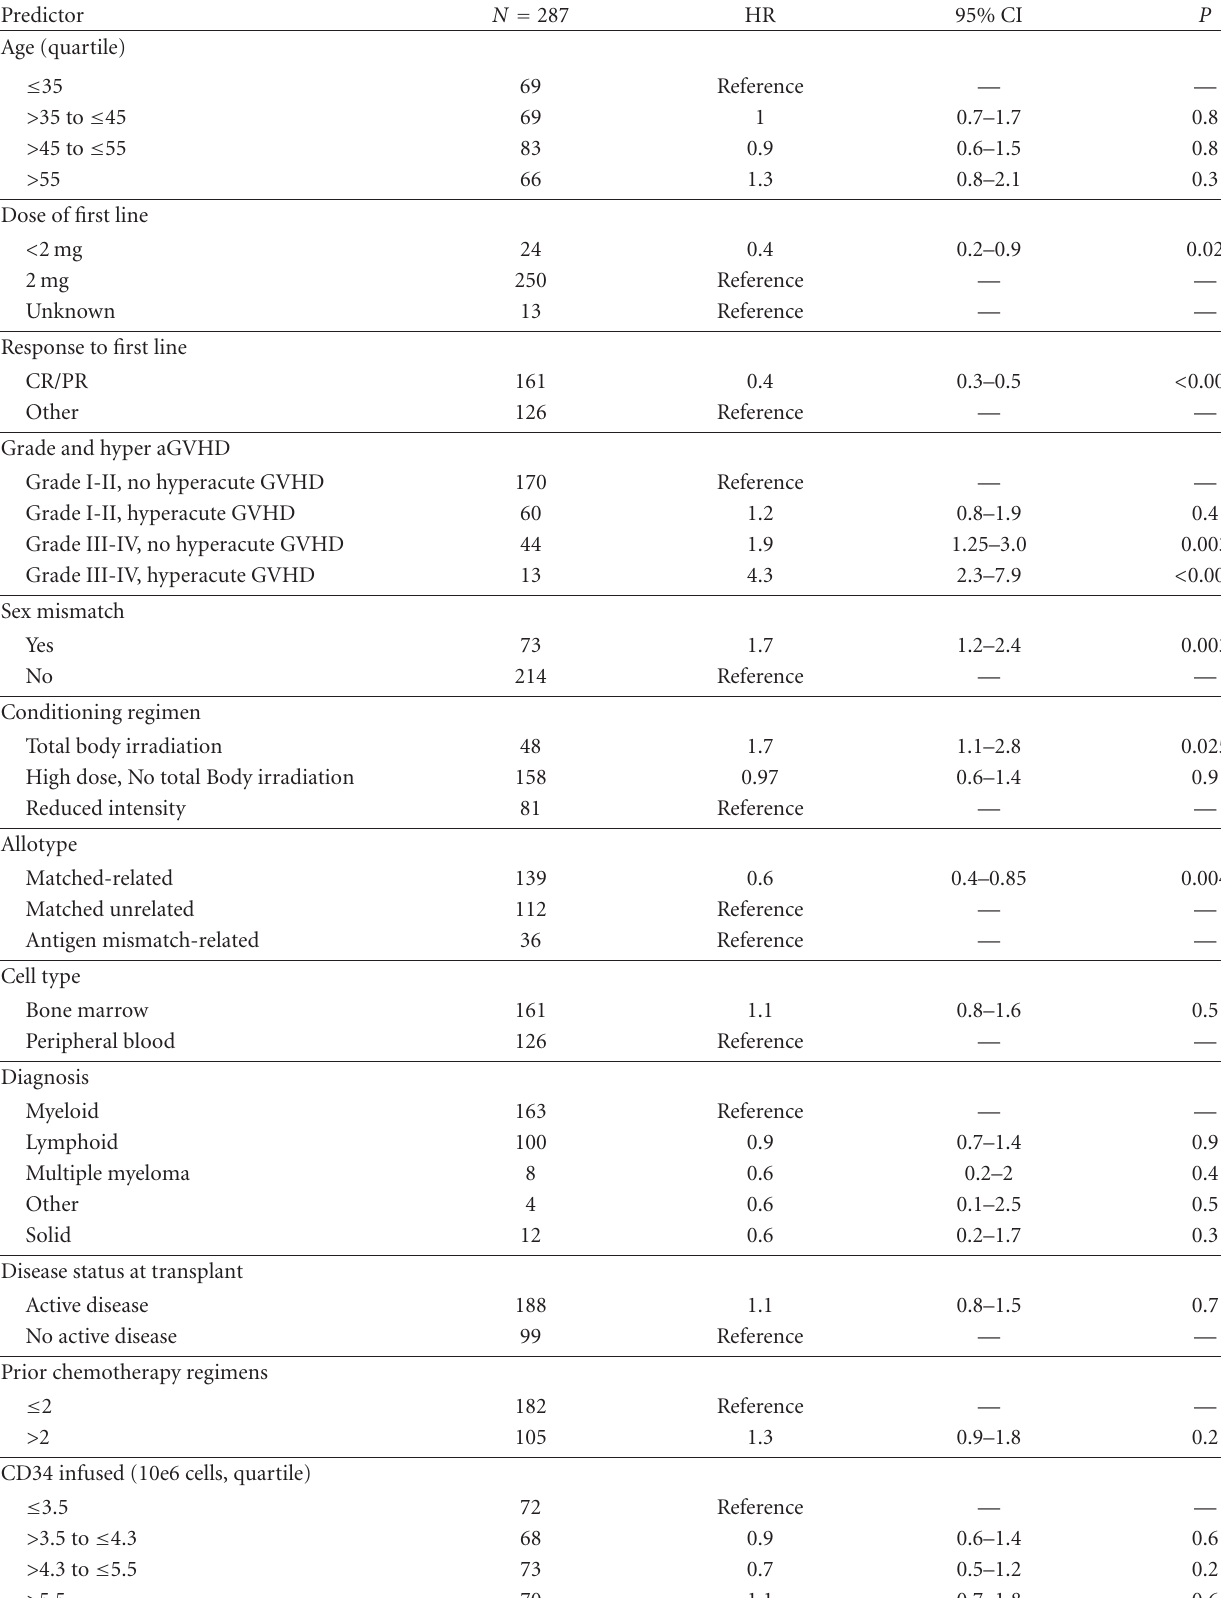
Table 5: Univariate predictors of nonrelapse morality among patients with acute GVHD at 2